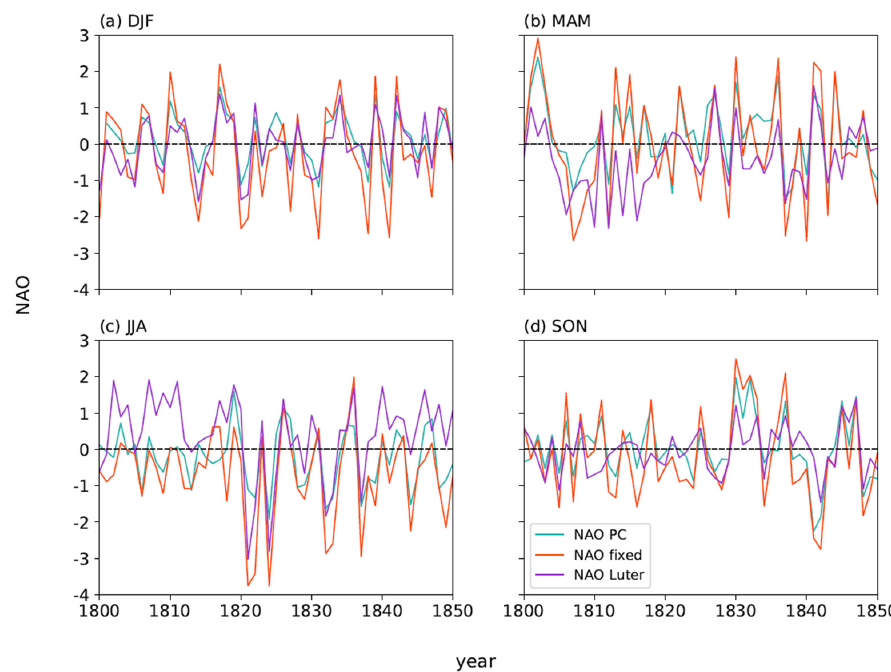
Figure 11. 1800–1850 seasonal series of NAO PC , NAO Fixed and NAO Luter for ( a ) winter (DJF), ( b ) spring (MAM), ( c ) summer (JJA) and ( d ) autumn (SON).